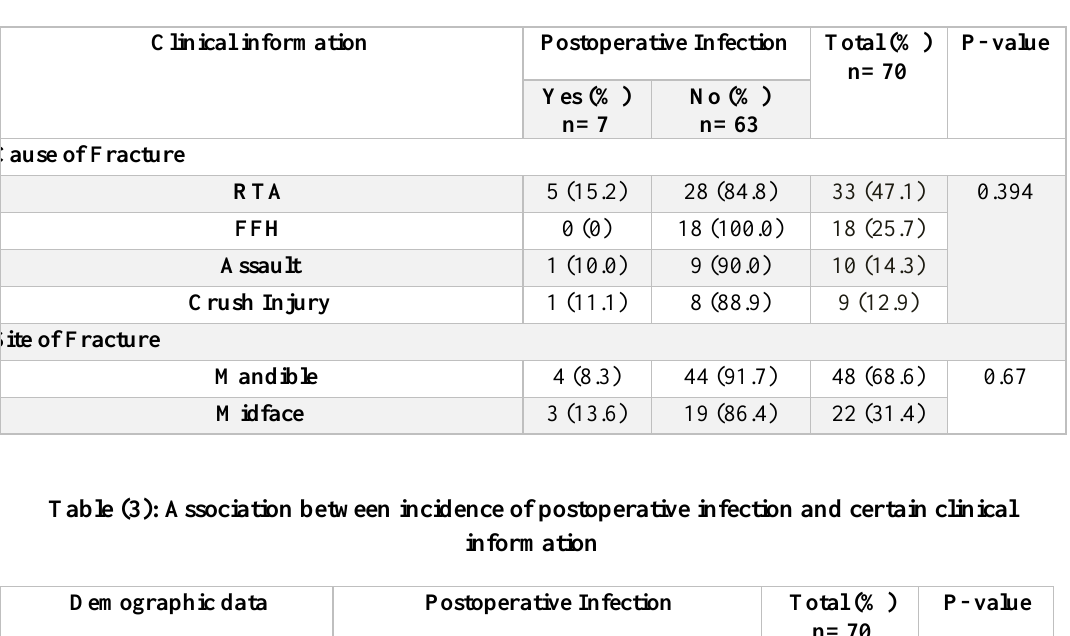
Table (2): Association between incidence of postoperative infection and demographic data